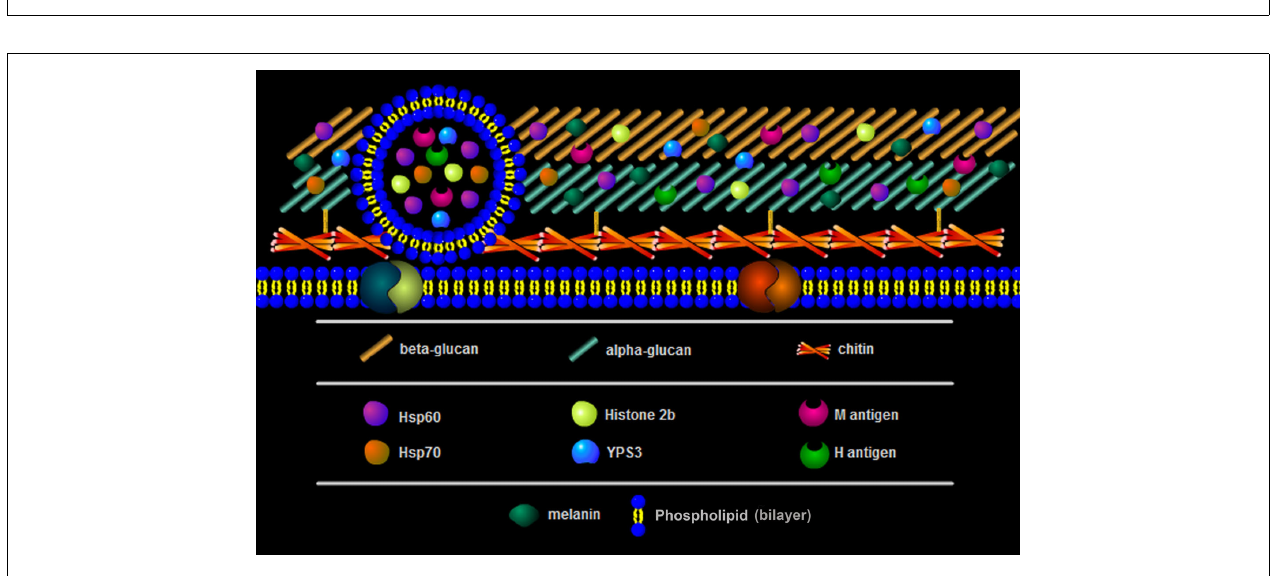
FIGURE 2 | Schematic model showing the composition of the Hc cell